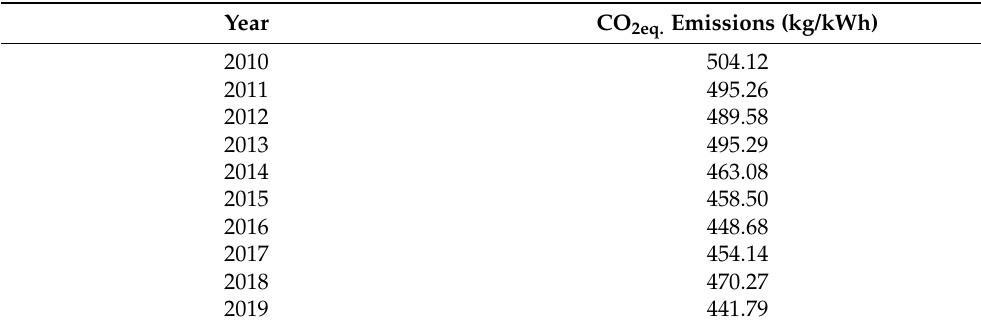
Table 3. The status of annual carbon dioxide–equivalent emissions in South Korea (adapted from national GHG inventory report and South Korean electric power statistics.) [44,49].